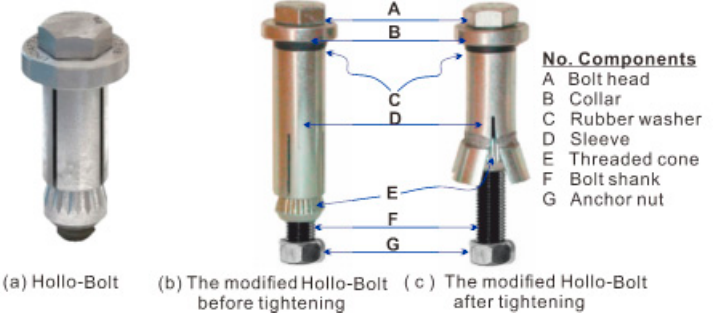
Figure 1. Modified anchored Hollo-Bolt. Table 1. Details of the test specimens.